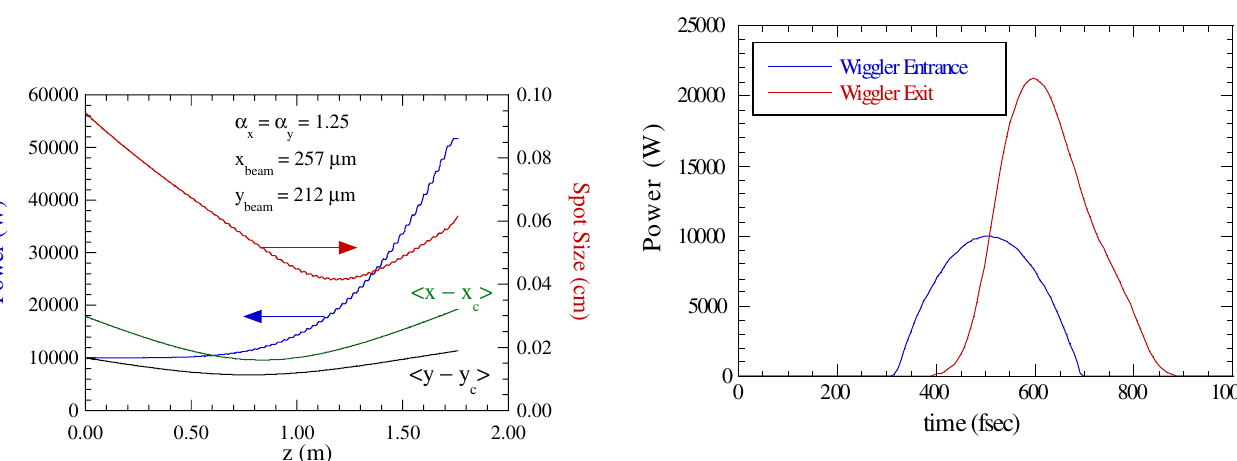
FIG. 2. (Color) Gain spectrum for an optimally focused electron beam.